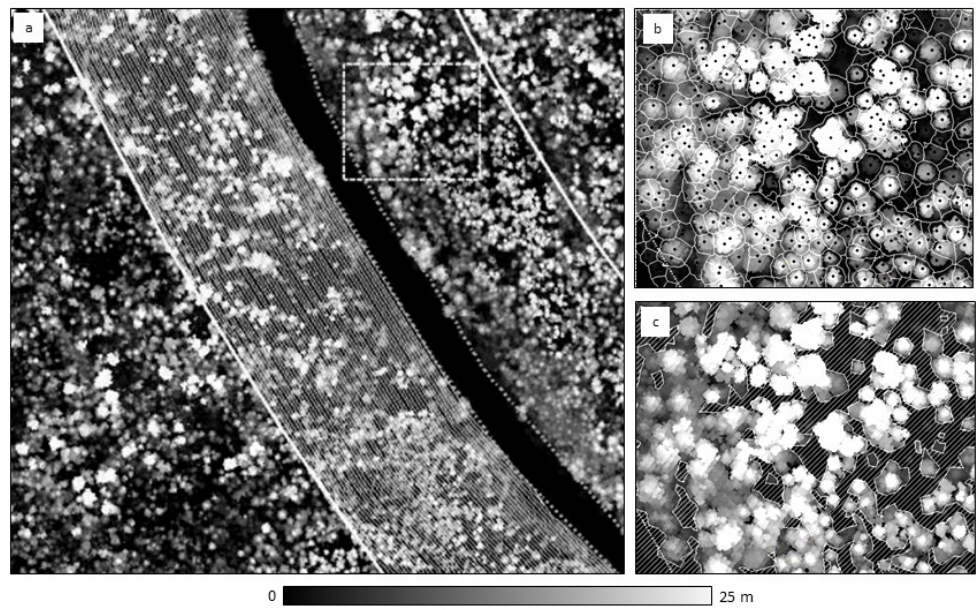
Figure 2. Extraction of detailed forest structural variables in a large contiguous area using a LiDAR CHM. ( a ) A sample CHM of the road overlaid with 100 m buffer (two thick white lines) and 2 m buffer rings (thin white lines). ( b ) Enlarged window of the dotted line box of size 100 m × 100 m indicated on ( a ) showing automatically delineated individual stems. ( c ) Window of the dotted box indicated on ( a ) showing automatically delineated canopy gaps (hashed polygons). CHM is a canopy height model, and increase in height is given by progressively lighter shades in all figures.